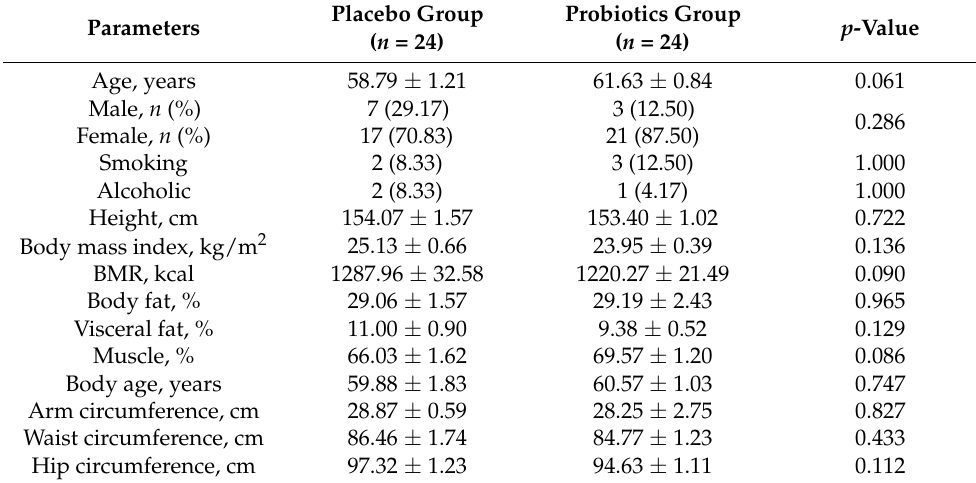
Table 1. The basic characteristics of the study